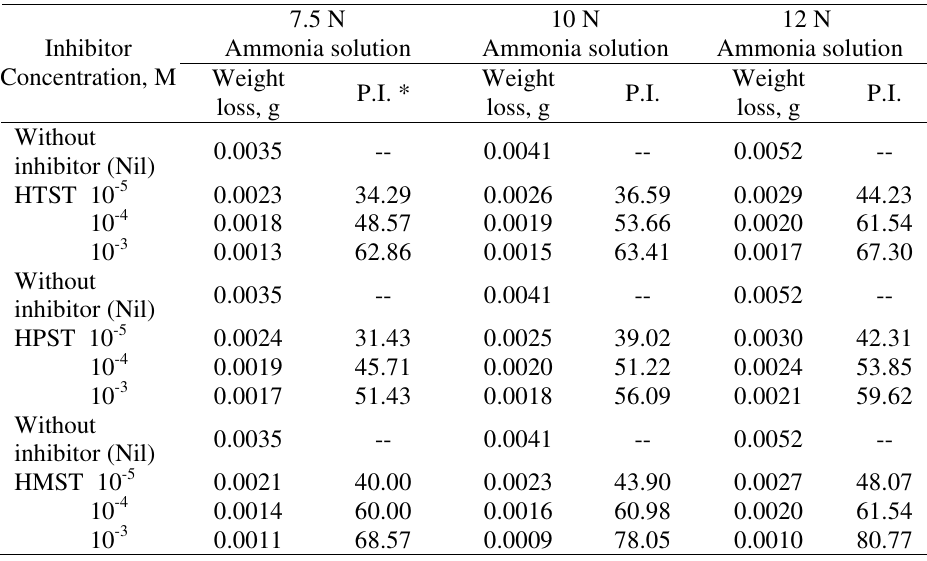
Table 1. Results of immersion test in ammonia solution with and without inhibitor at temperature 30ºC and immersion period 24